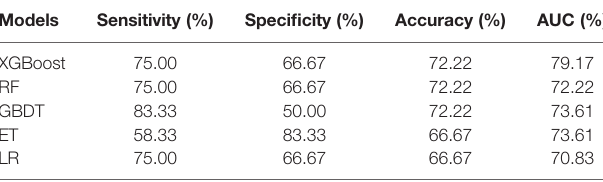
TABLE 2 | The results of predictive performance of the